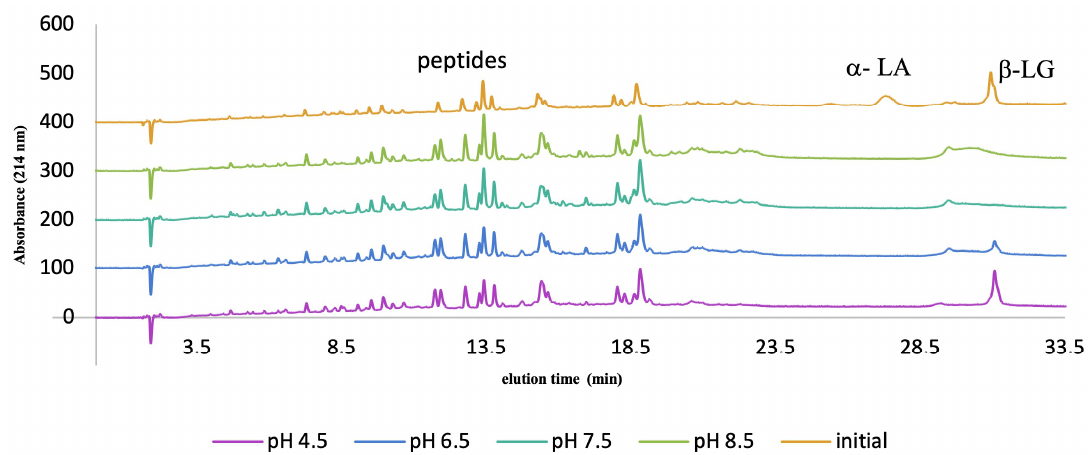
Figure 3. Reverse-phase high-performance liquid chromatography profiles of a tryptic hydrolysate of whey protein isolate at different pH values (4.5, 6.5, 7.5, and 8.5) following water bath heating to 85 °C for 20 min for the purpose of trypsin inactivation. α-LA(α-lactalbumin) β-LG (β-lactoglobulin).